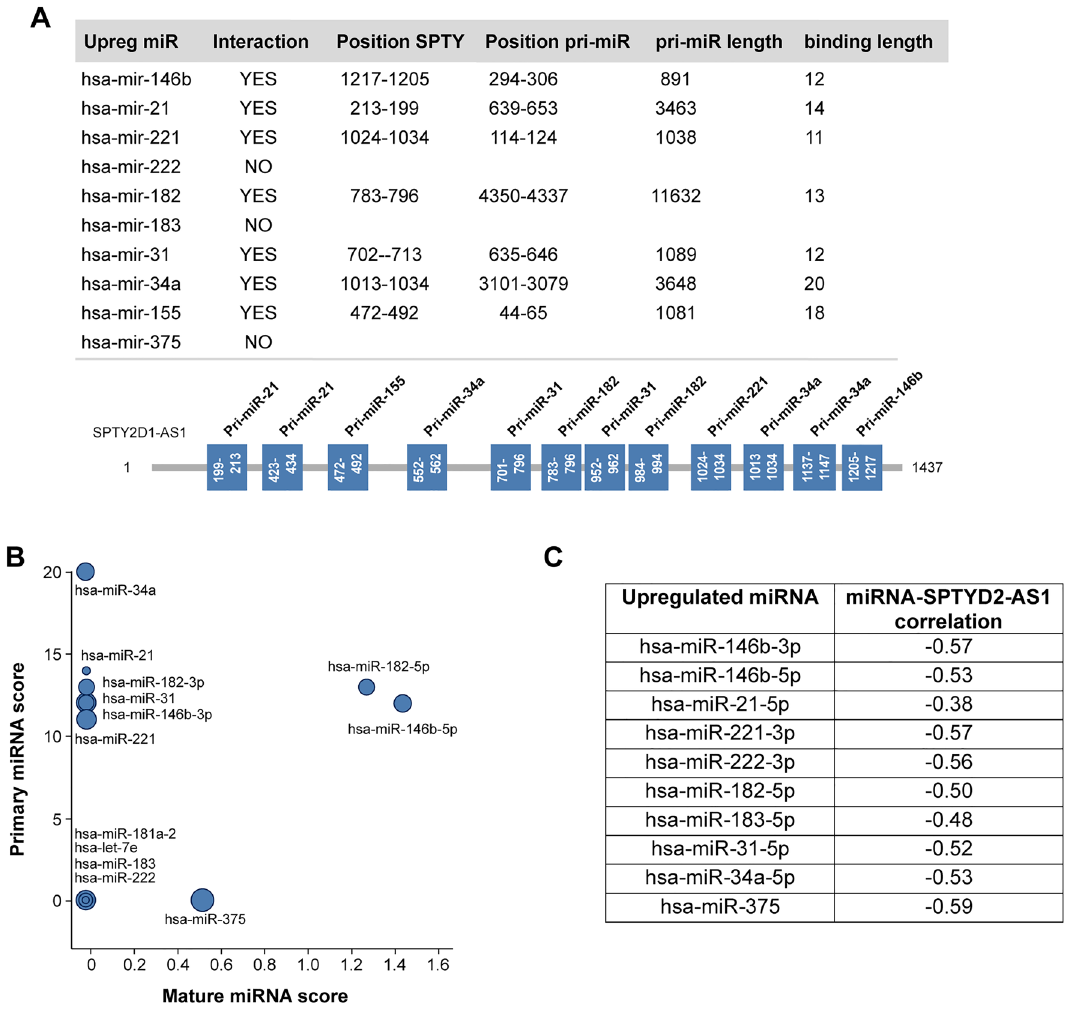
Figure 2. SPTY2D1-AS1 is predicted to impair the biogenesis of oncogenic miRNAs. ( A ) SPTY2D1-AS1 is predicted to target key oncogenic pri-miRNAs. Upper panel: Using Blast for sequence alignment (as described in Ref 29), we determined that SPTY2D1-AS1 putatively binds to the indicated pri-miRNAs. Lower panel: Schematic representation of pri-miRNA binding sites in the SPTY2D1-AS1 sequence. ( B ) Potential